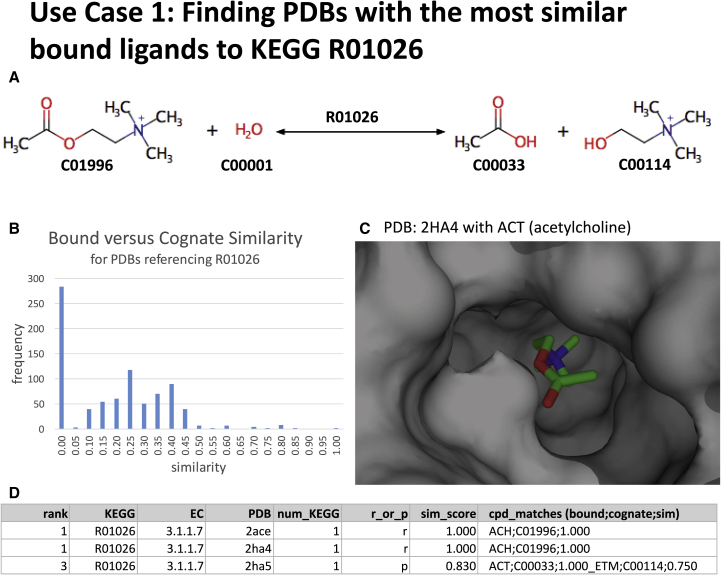
Use Case 1Graphic shows (A) the KEGG reaction for R01026 (acetylcholine acetylhydrolase); (B) the distribution of similarity scores between the cognate ligands and the bound ligands in PDBs referencing R01026; (C) a representation of the binding pocket of the one of the best matches, PDB: 2HA4 (crystal structure of mutant S203A of mouse acetylcholinesterase complexed with acetylcholine), with bound acetylcholine; and (D) an extract from the Mendeley Data Repository for R01026. (In D num_KEGG refers to the number of KEGG reactions potentially matched to the PDB via the EC in SIFTS, r_or_p refers to whether reactants [r] or products [p] have been matched, and cpd_matches details the bound and cognate matched ligands in the format bound; cognate; similarity_score with multiple matches separated by an underscore.)